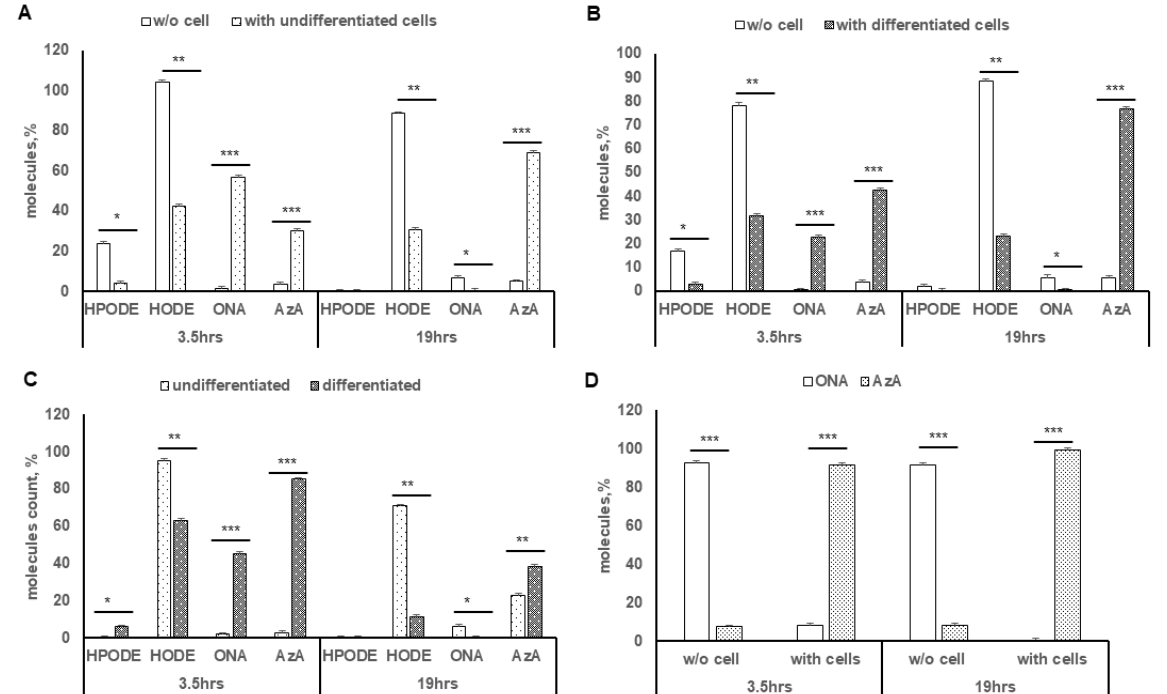
Figure 4. Degree of 13-HPODE and 9-ONA decomposition in media with presence and absence of Caco-2 cells at 3.5 h and 19 h post-treatment: ( A ) undifferentiated Caco-2 cells compared with cell-free media; ( B ) differentiated Caco-2 cells compared with cell-free media; ( C ) decomposition products of 13-HPODE after saponification of intracellular lipid extract from poorly and fully differentiated Caco-2 cells; ( D ) conversion of 9-ONA to AzA in presence and absence of fully differentiated Caco-2 cells. ( n = 3; * p < 0.05; ** p < 0.01; *** p < 0.001 ).